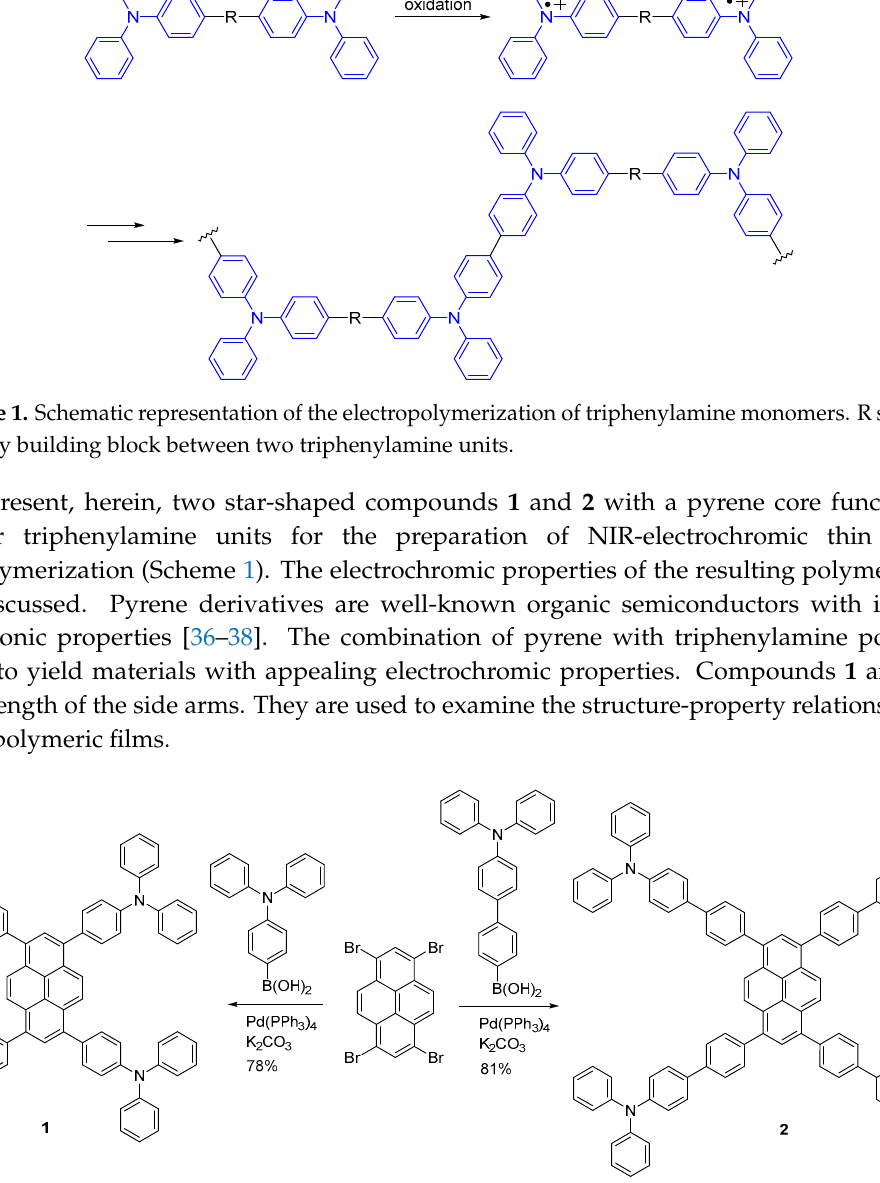
Scheme 1. Synthetic routes of compounds 1 and 2.